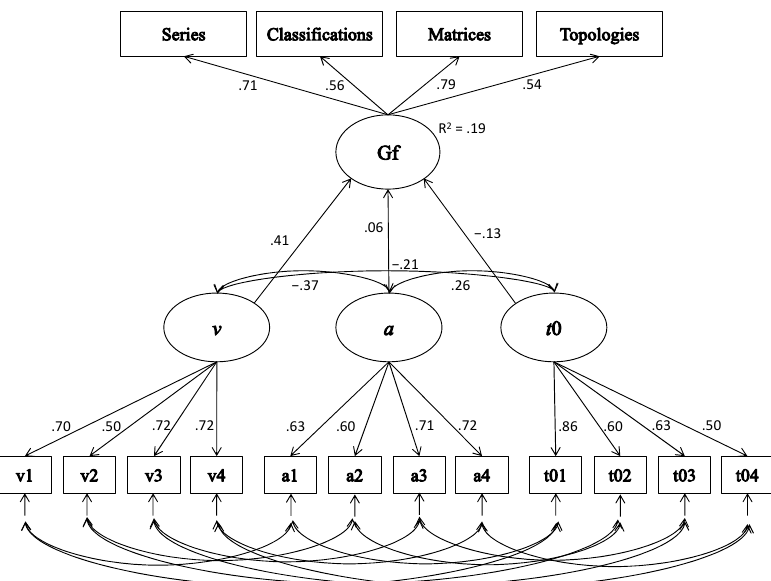
Figure 2. Simplified graphic of the prediction of fluid intelligence (gf) with the DDM parameters drift rate ( v ), boundary separation ( a ) and non-decision time ( t 0).